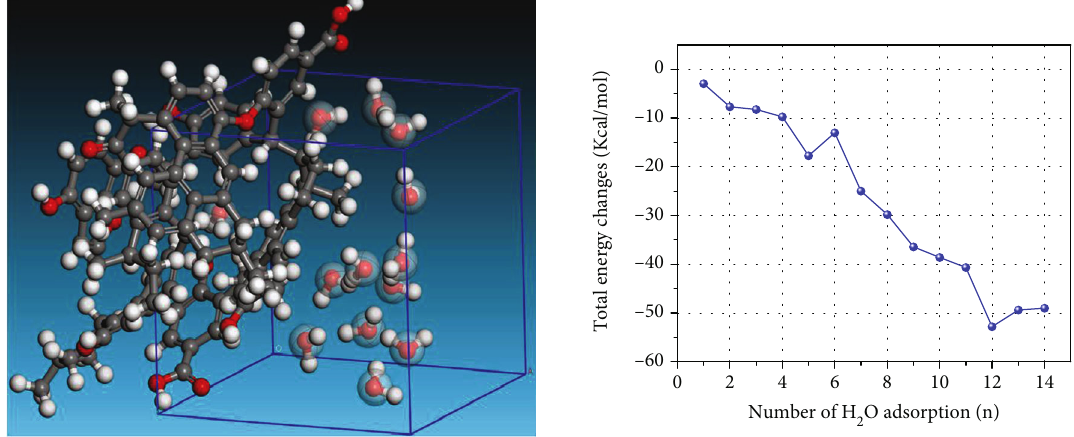
Table 4: Single-component isothermal adsorption data of the long- fl ame coal molecule to methane molecules and water molecules. Pressure Average adsorption amount (mmol/g) (MPa) of CH 4